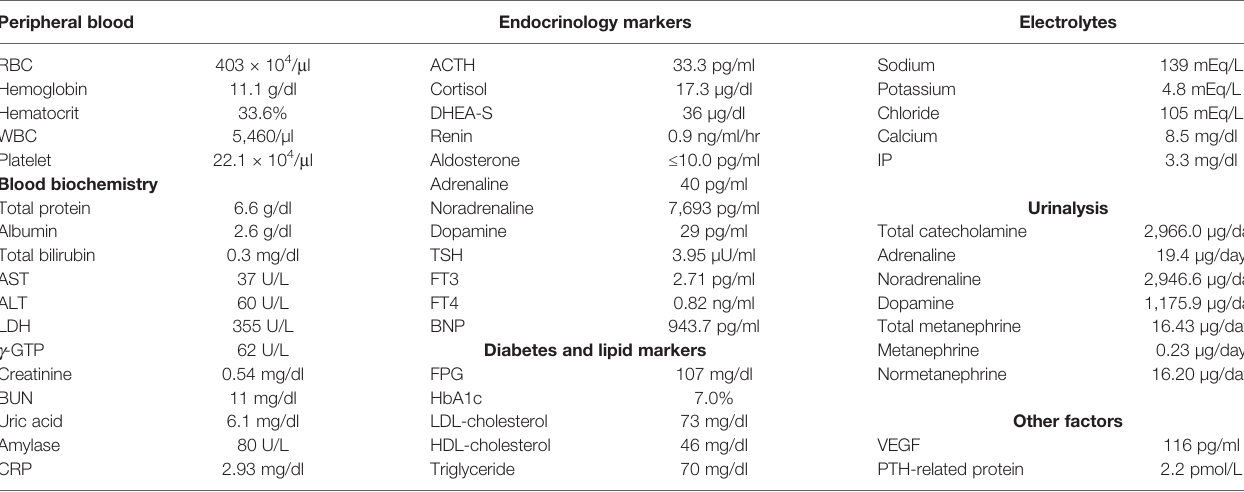
TABLE 1 | Laboratory data on admission in this subject. Peripheral